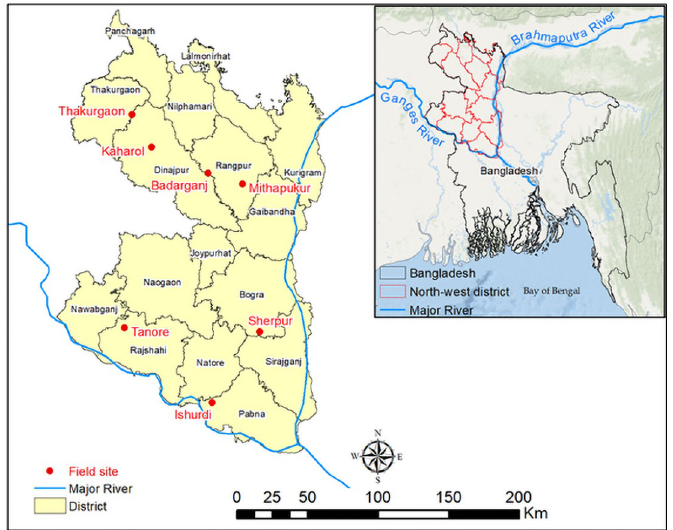
Fig 1. Location of the selected sites (solid circles) for monitoring and data